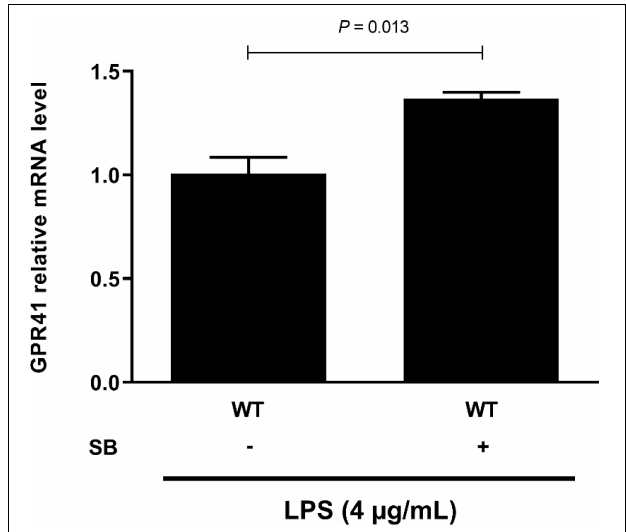
FIGURE 6 | Sodium butyrate promoting the gene expression of GPR41. Generation of GPR41-knockdown (GPR41KD) BREC cell lines using the CRISPR/Cas9 system. BRECs were pretreated with SB (0 and 0.5 mM) for 18 h and then treated with 4 µ g/mL LPS for 6 h. The gene expression of GPR41 was detected by qRT-PCR. The values are shown as mean ± SEM ( n =